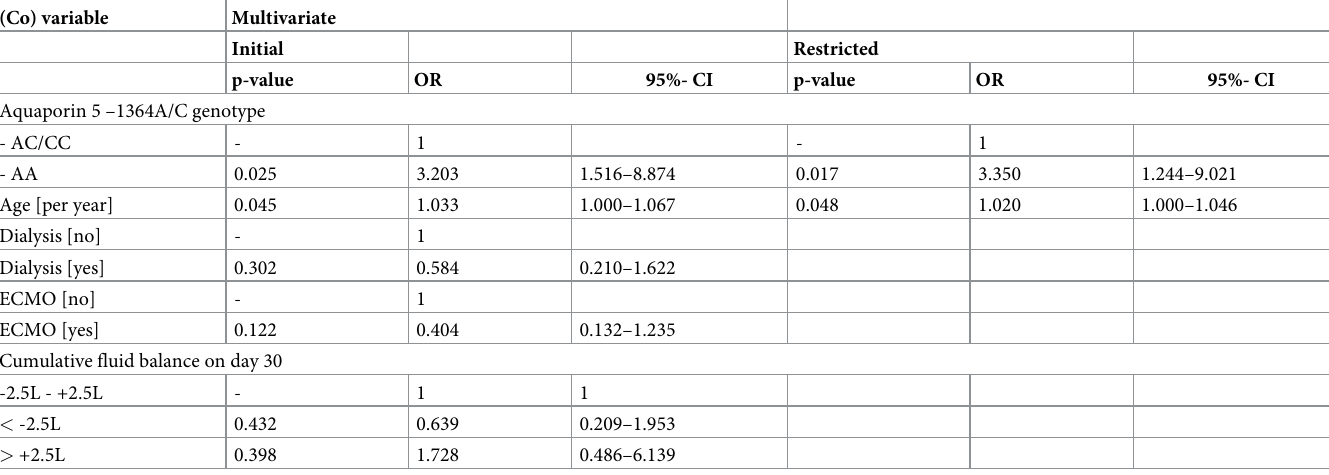
Table 3. Factors independently associated with AKI after adjustment for confounders (stepwise logistic